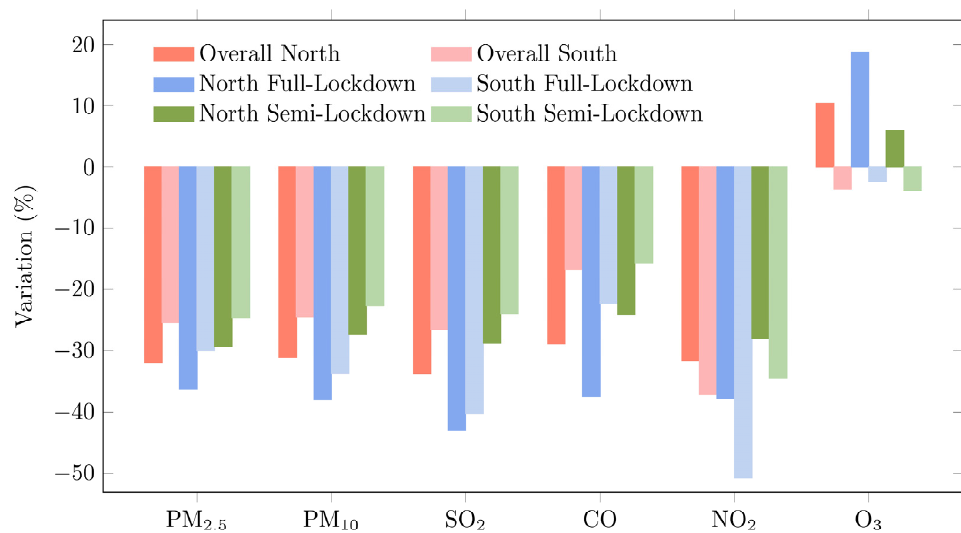
Figure 4. The variation of multiple airborne pollutants in northern and southern China.